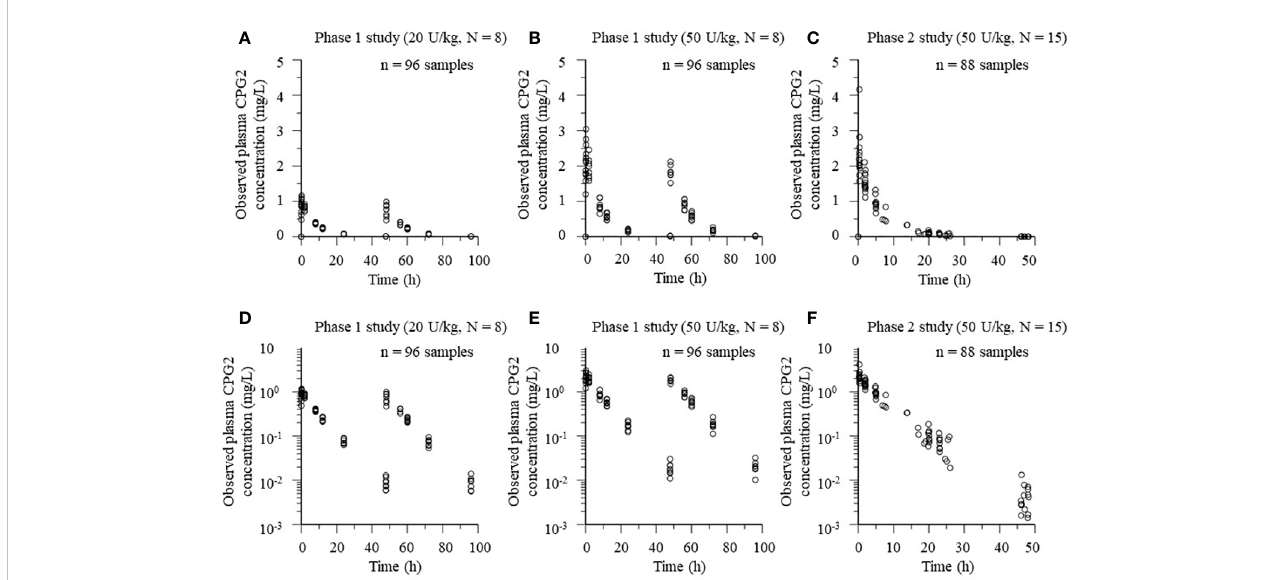
Figure 6. The plasma MTX concentration versus time curves showed a graphically good re fl ection of the alterations of reduced and rebound in plasma MTX concentrations after the administration of CPG2 (Figure 7). The sampling strategies, including the smallest value of predictive performance, were as follows: 2-point sampling (before CPG2 dosing plus 24 h after dosing) and 3-point sampling (before CPG2 dosing plus 20 min and 24 h after dosing), with ME = − 0.056 and 0.03, MAE = 0.458 and 0.543, and RMSE = 0.729 and 0.896, respectively. The relationship between sampling points and RMSE is shown in Figure 7.